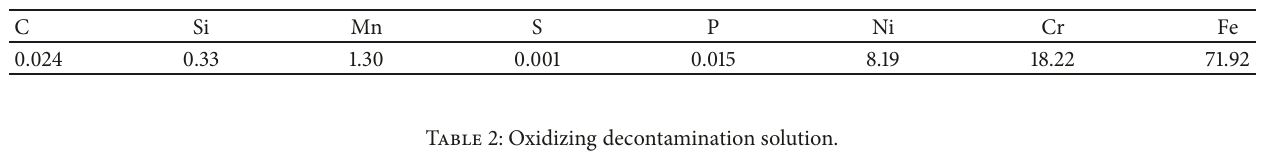
Table 1: Chemical compositions of tested 304L SS (mass. %).